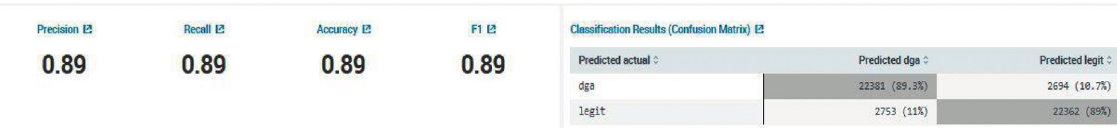
Figure 10: Results of evaluation based on logistic regression algorithm without using principal component analysis feature.